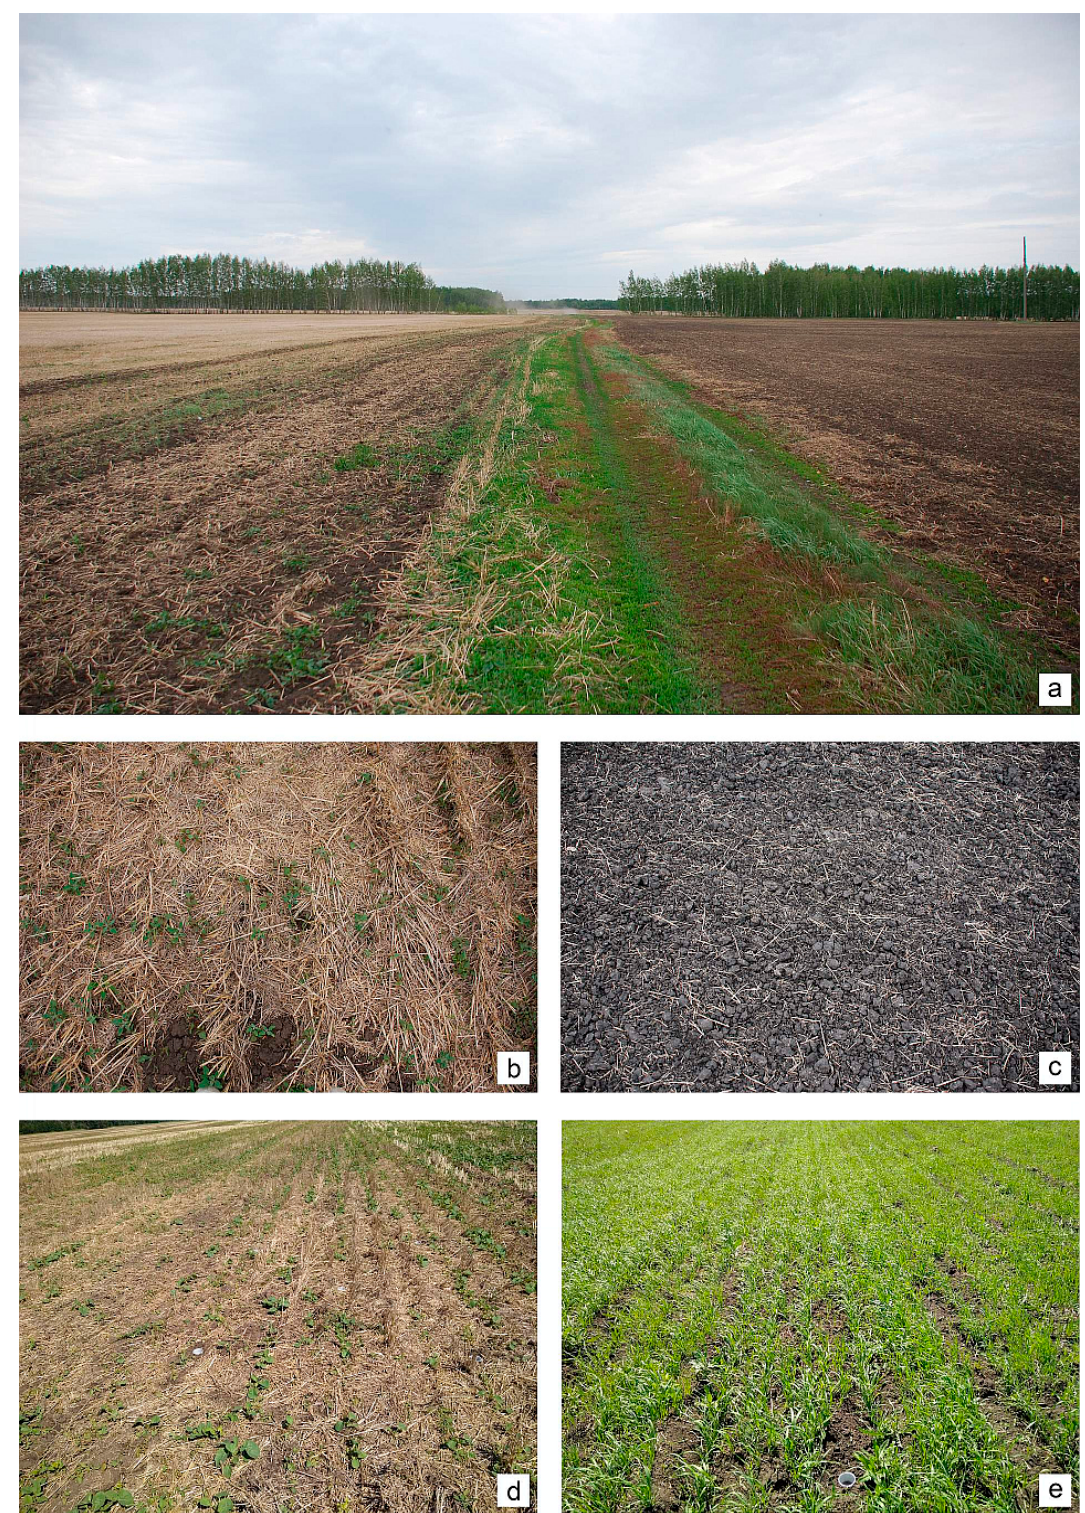
Figure 1. General view of the agricultural field with plots of conventional plowing and no-tillage. ( a ) No-till plot (left) and conventional tillage plot (right), 22 May 2017; ( b ) no-till plot, 22 May 2017, closer; ( c ) plot with conventional tillage, 22 May 2017, closer; ( d ) pitfall traps at the no-till plot, 20 June 2018; ( e ) pitfall traps at the plot with conventional tillage, 20 June 2018. For our research, we selected a study area of an agricultural field where no-tillage (NT) has been used since 2007 and a control area with conventional tillage (CT). These